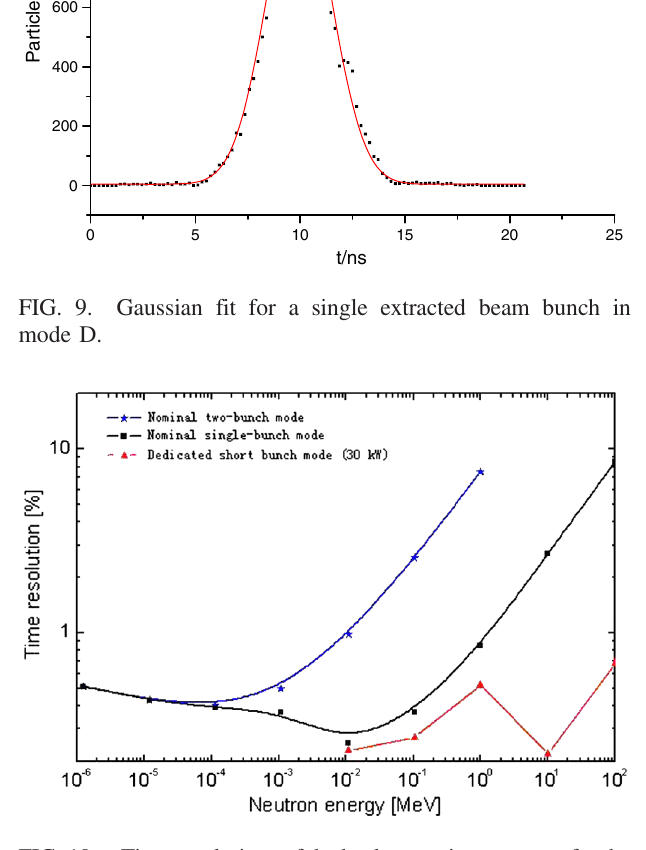
FIG. 10. Time resolutions of the backstreaming neutrons for the nuclear data measurements using the time-of-flight method.